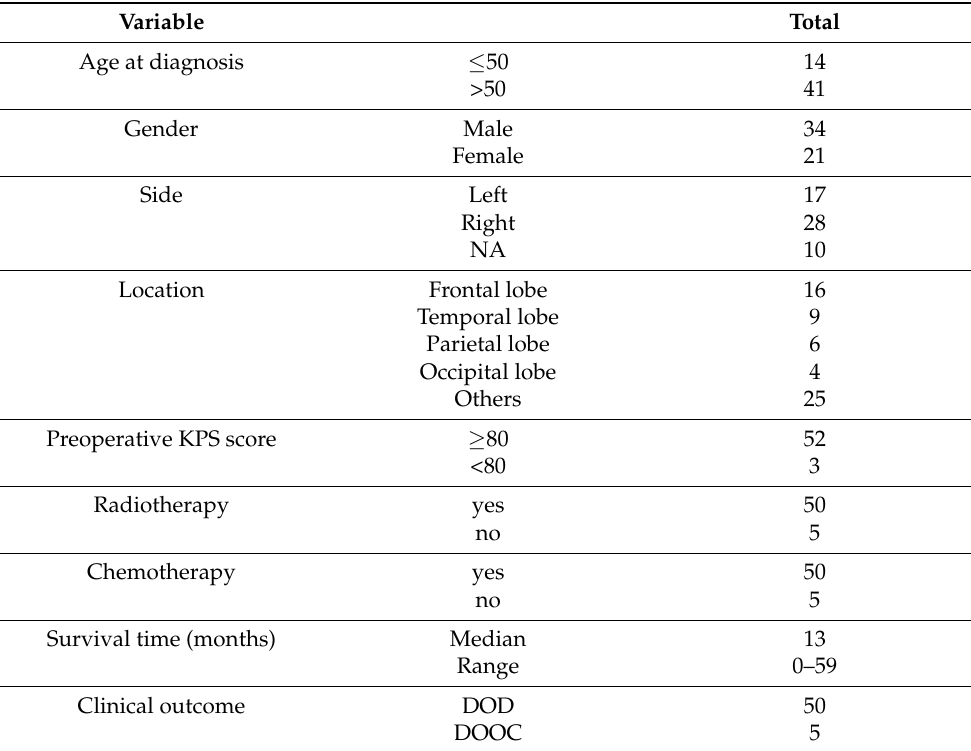
Table 1. Clinicopathological characteristics of 55 patients with primary GBM